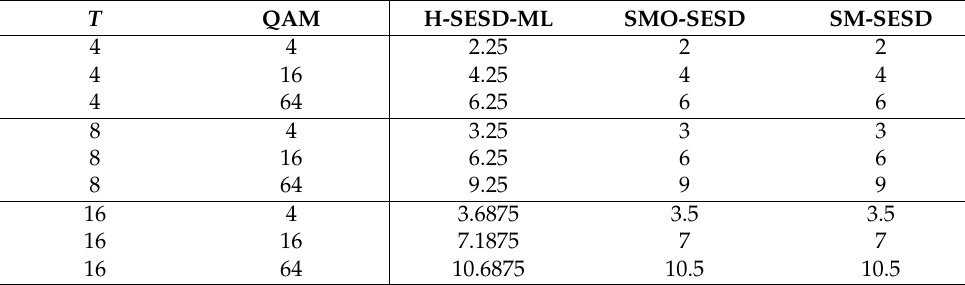
Figure 11. Performance comparison of three PSAMs constructed from rectangular QAM, their orthonormalization, and a constellation constructed using the hypercube method with the same QAM. All results are obtained for a channel with T = 16 and M = N = 2. Table 1. Bits per channel use transmitted for each